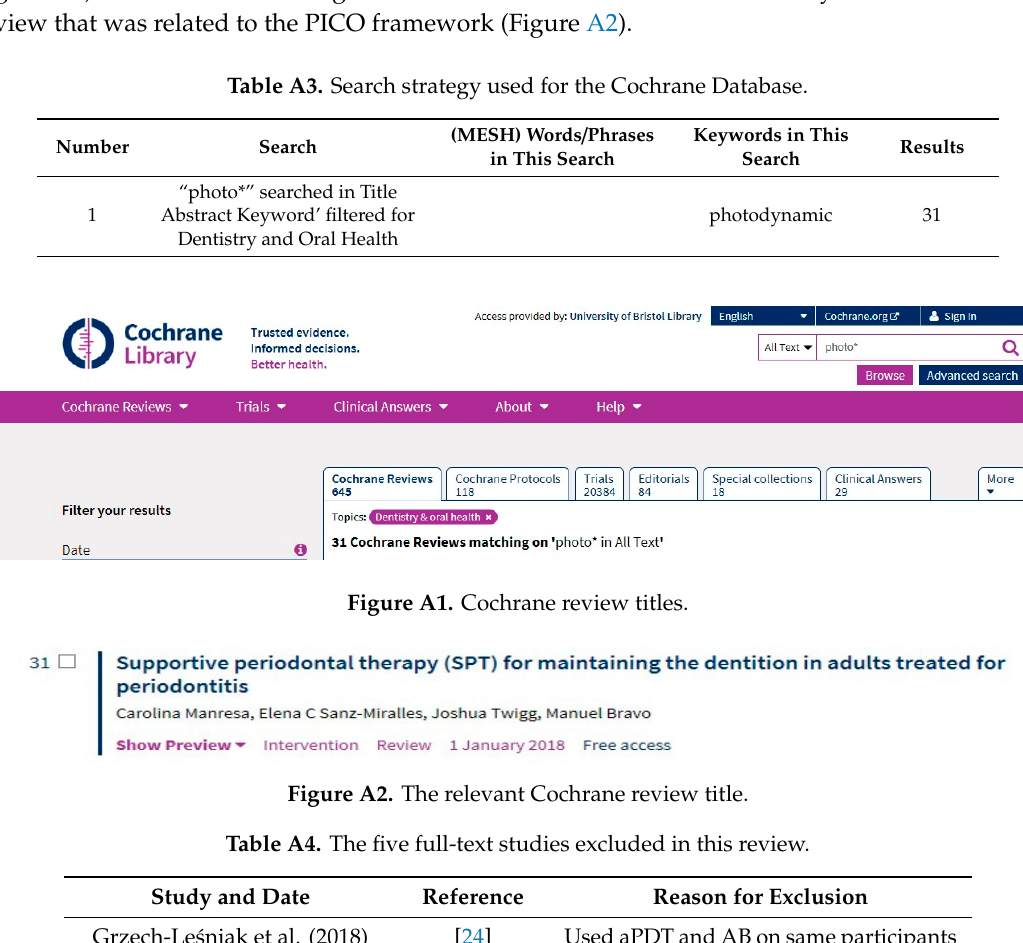
Table A3. Search strategy used for the Cochrane Database.